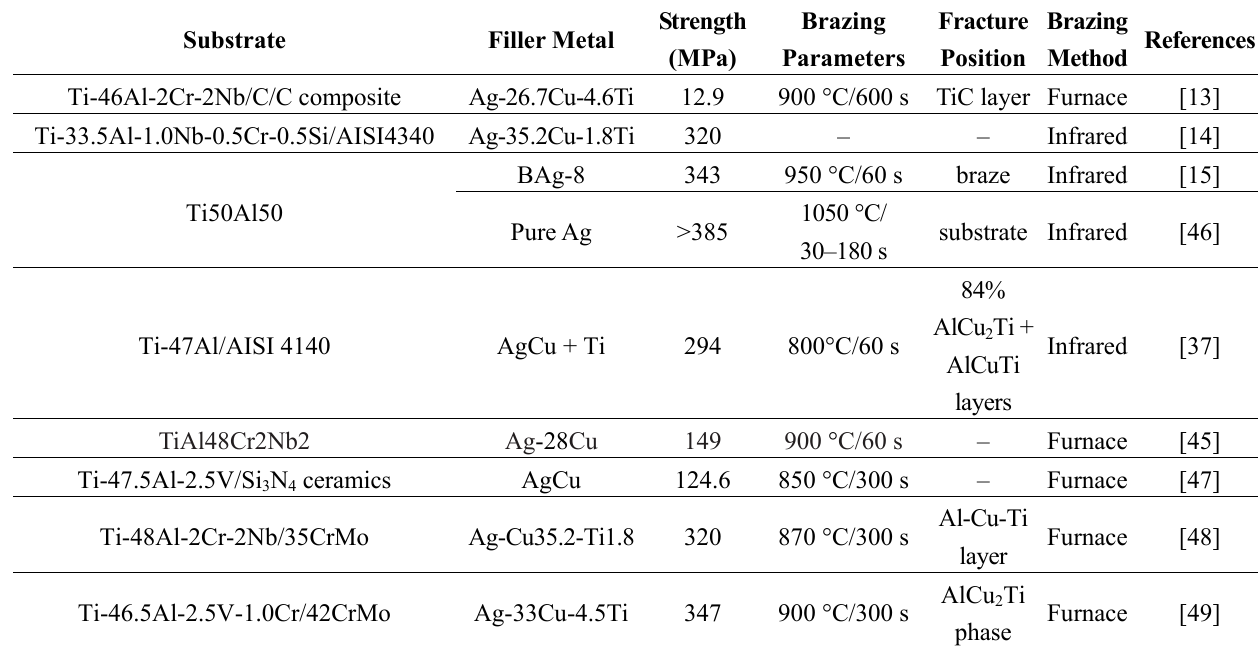
Table 3. The mechanical properties of titanium aluminides brazed joint using Ag-based filler